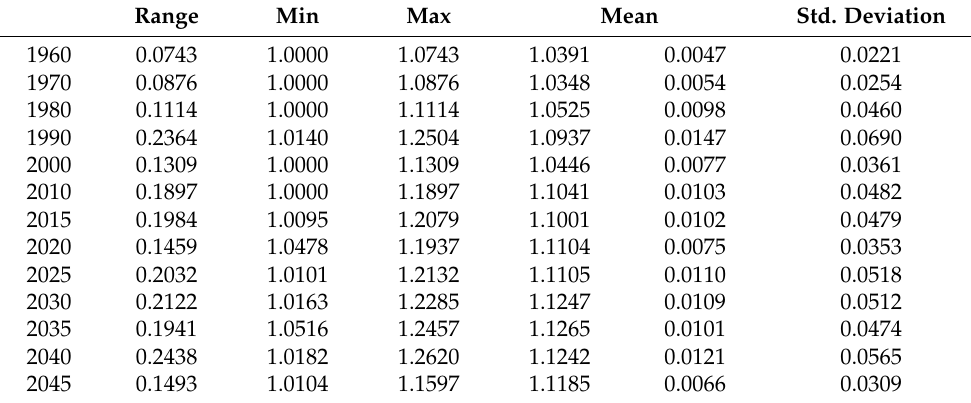
Table 2. Descriptive statistics